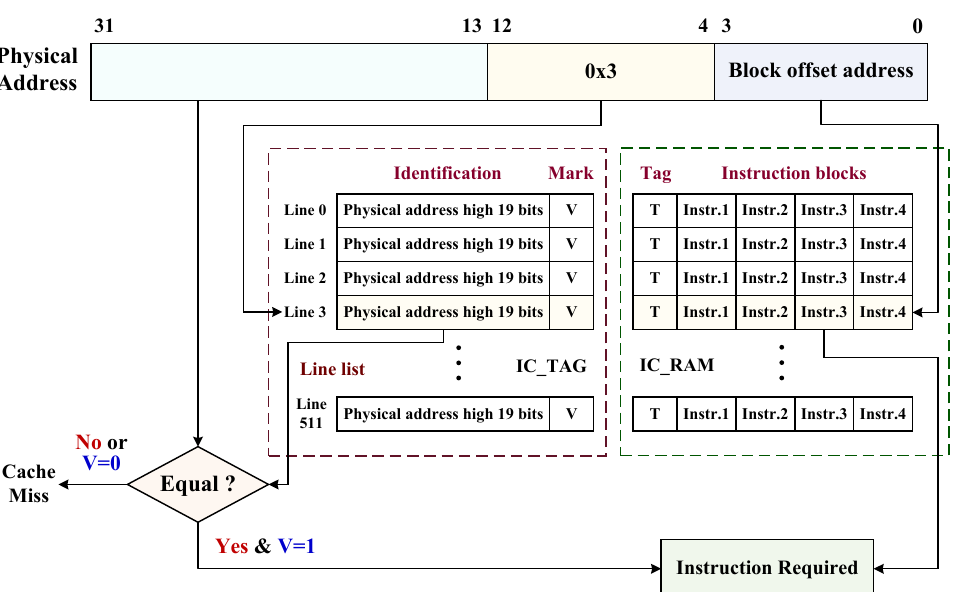
Figure 10. The internal implementation mechanism of the I-Cache with the size of 8